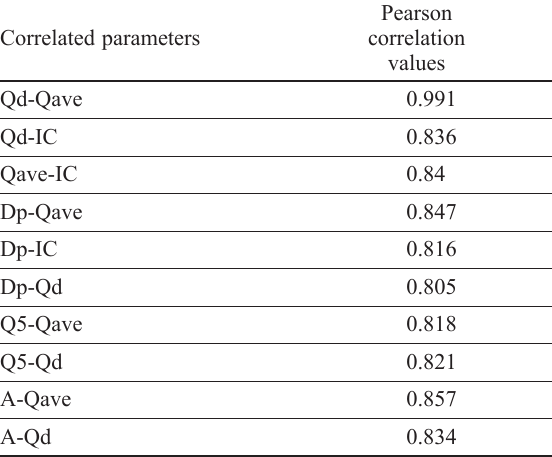
Table 2. Highly correlated variable pairs and correlation coefficient Correlated